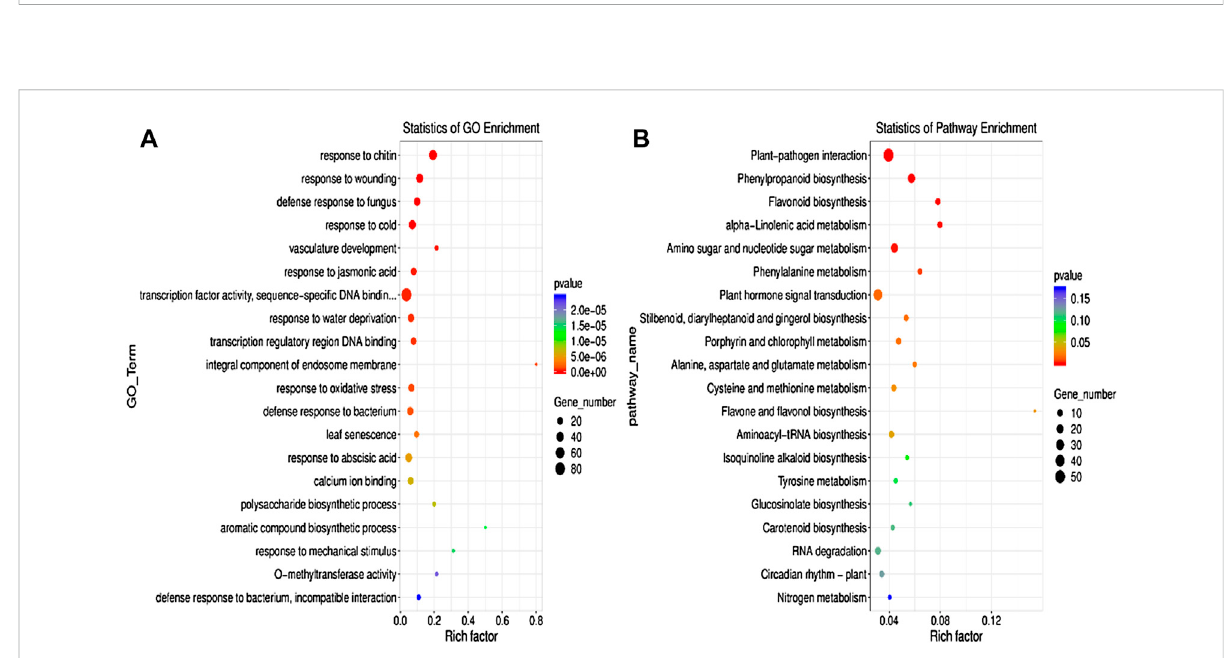
FIGURE 5 GeneOntology(GO)( A) pathwayandKEGG (B) pathwayenrichmentanalysesofDEGsbetweenthecontrolandAR-Cdtreatedgroups.Therich factor indicates the degree of enrichment of the GO items and KEGG